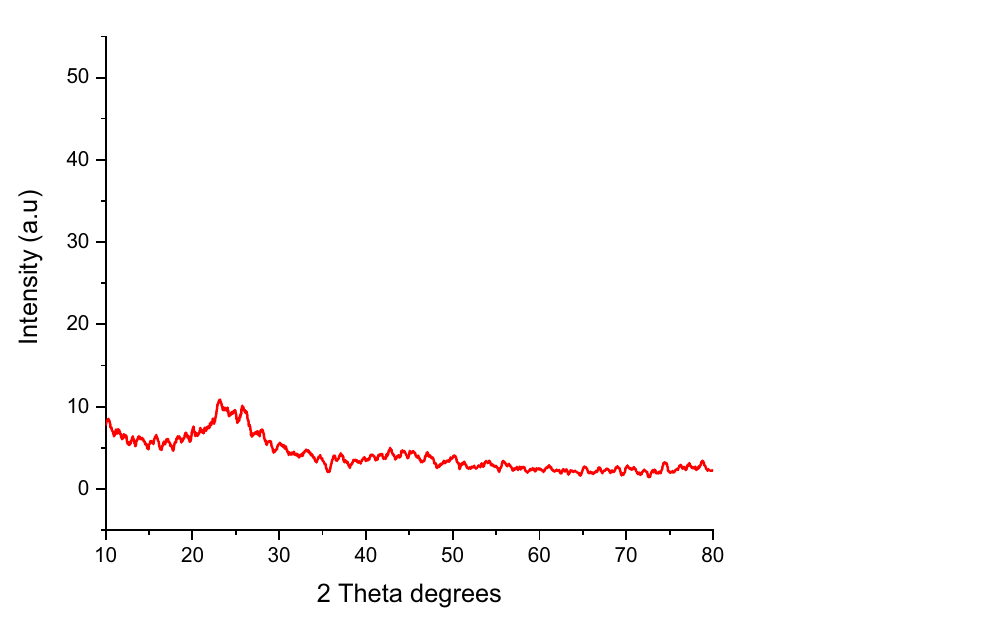
Figure 5. XRD image of Rumex abyssinicus activated